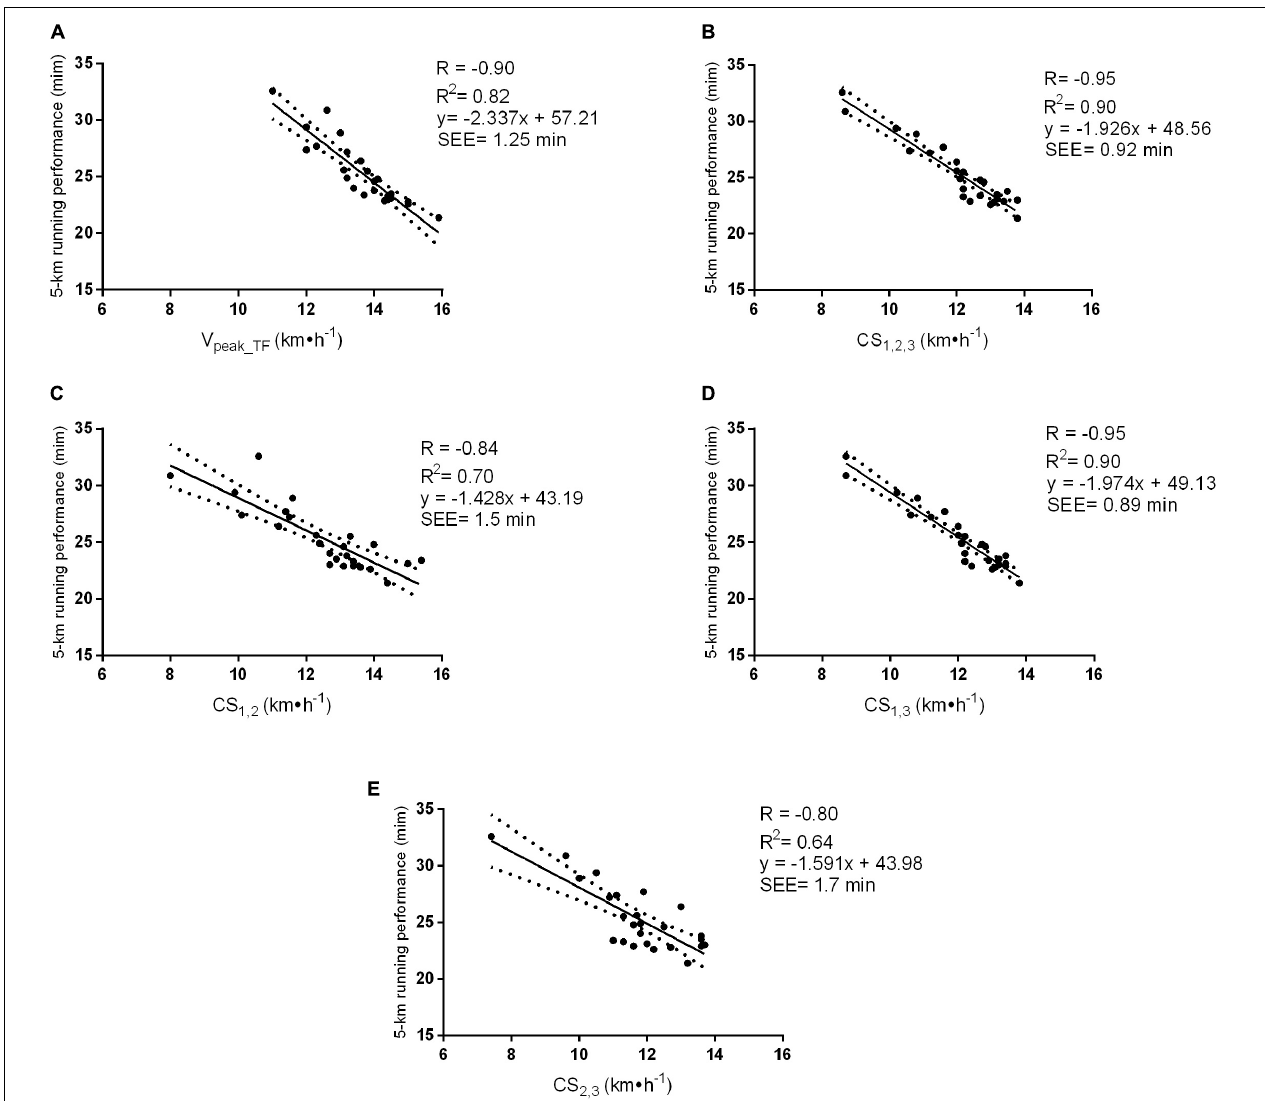
FIGURE 1 | Correlation and linear regression between the (V peak_TF ) (A) , CS 1 , 2 , 3 (B) , CS 1 , 2 (C) , CS 1 , 3 (D) , and CS 2 , 3 (E) with the 5-km running performance time in minutes ( n = 25). SEE: standard error of the estimate; V peak_TF : Peak running velocity determined on the track field; CS 1 , 2 , 3 : Critical speed at 2,600, 1,800 and 1,000 m; CS 1 , 2 : Critical speed at 2,600 and 1,800 m; CS 1 , 3 : Critical speed at 2,600 and 1,000 m; CS 2 , 3 : Critical speed at 1,800 and 1,000